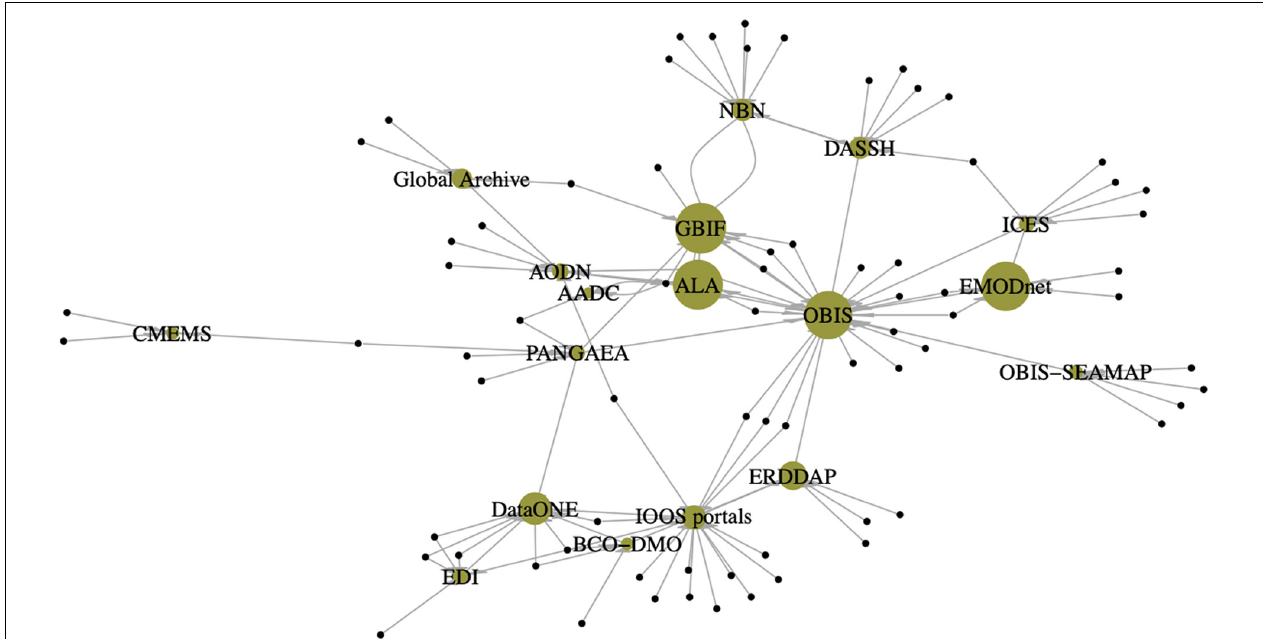
FIGURE 5 | Network displaying data repositories, aggregators, or other data serving platforms (green circles; n = 18) and observing programs (small black circles; n = 73). Data servers and associated observing programs were only included in instances where three or more observing programs indicated that they provided data to a given data serving platform, in order to clearly display the most common data servers. The node size is scaled by the number of observing programs that provide data to a given data server, whether directly or through another intermediary. Larger nodes indicate data serving platforms with higher numbers of biological observing program datasets, whether the data were provided directly from the observing program or indirectly to the repository from another data repository (Acronyms are defined in Table 1 ).